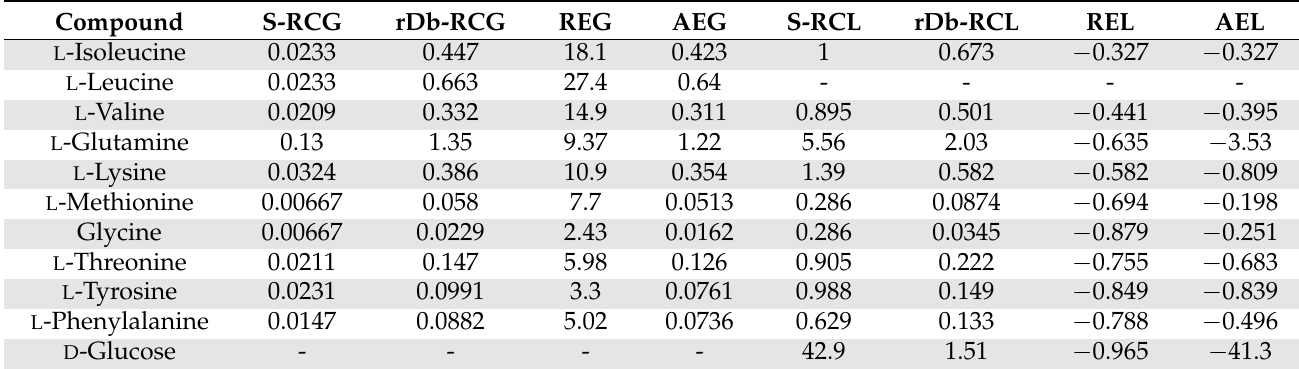
Table 5. Results from the rDolphin quantifier with the blood profile. The column headings are defined for this quantifier (with prefix rDb- ) analogous to the caption of Table